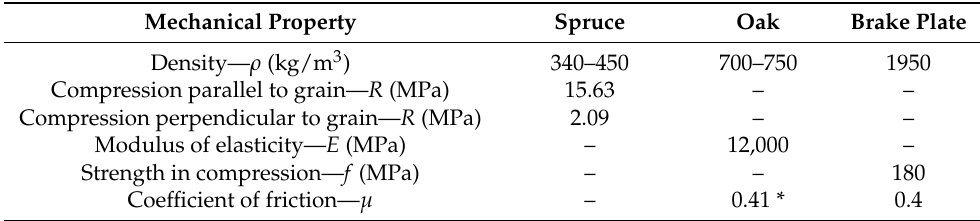
Table 1. Material characteristics.